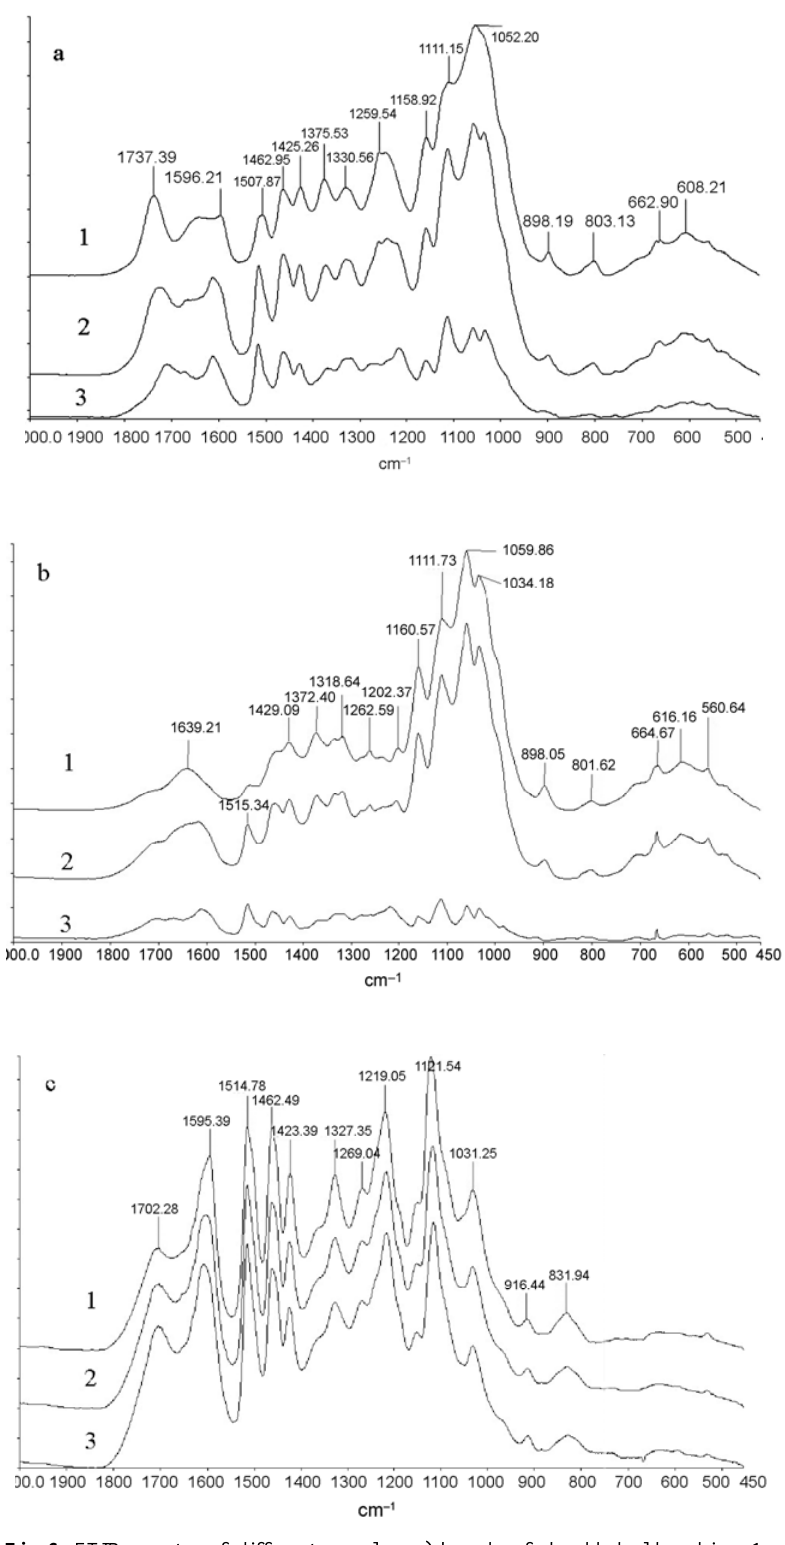
Fig. 6. FTIR spectra of different samples: a) boards of shredded alder chips; 1 – binder-less boards of shredded alder chips (B1); 2 – self-binding boards of shredded alder chips mixed with SE lignin at the proportion 4:1 (B2); 3 – difference between spectra 1 and 2; b) boards of ground SE cellulose; 1 – self-binding boards of ground SE cellulose (B3); 2 – self-binding boards of ground SE cellulose mixed with SE lig- nin at the proportion 4:1 (B4); 3 – difference between 1 and 2; c) SE air-dry (6%) Lignin; 1 – 1 min treatment time SE Lignin (L1b); 2 – 2 min treatment time SE Lignin (L2b); 3 – 3 min treatment time SE Lignin